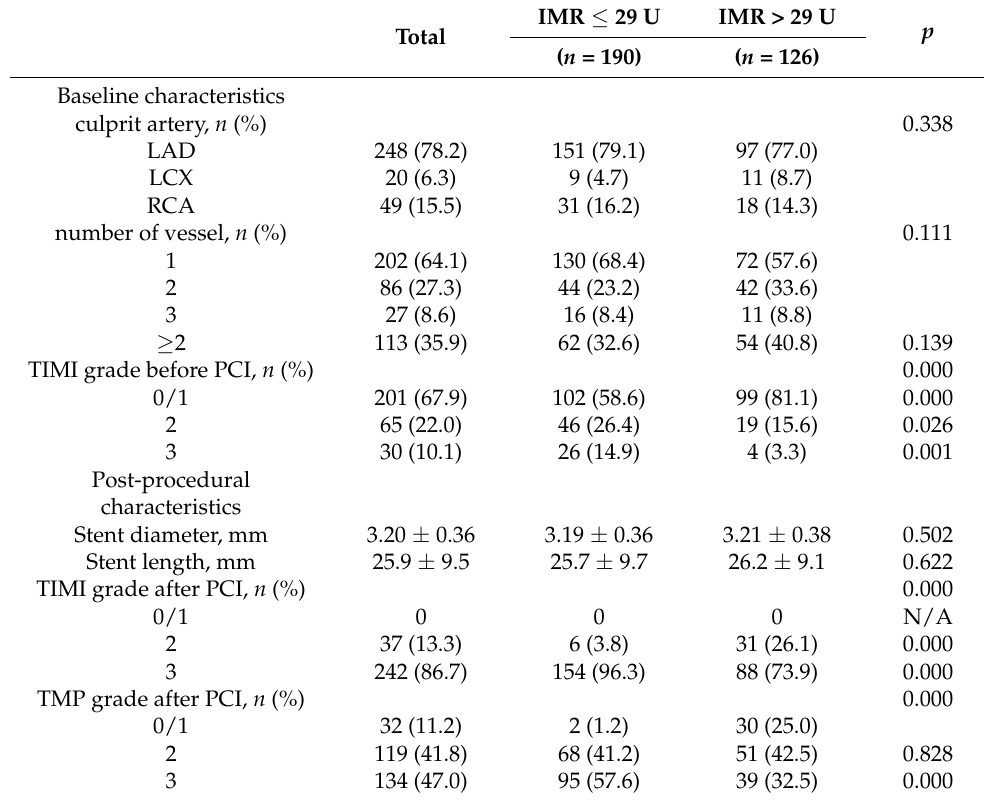
Table 3. Angiographic